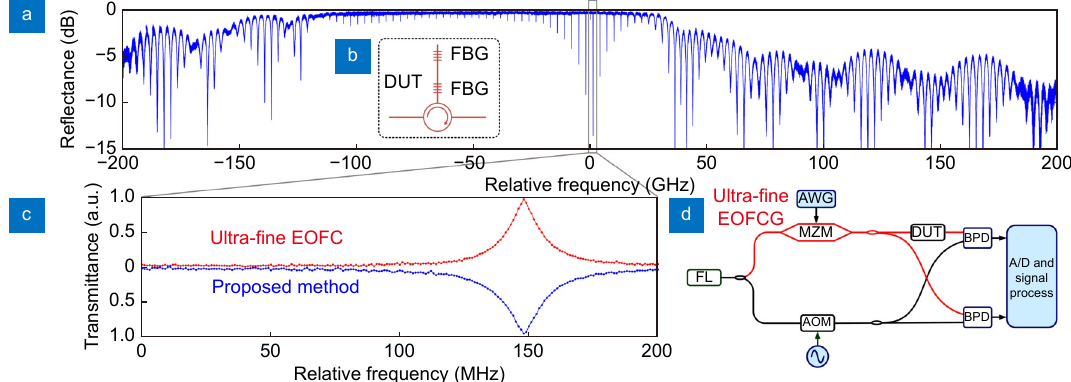
Fig. 5 | ( a ) Reflectance spectrum measured in 1.6 ms with 1 MHz resolution. ( b ) Experimental setup of the fiber F-P cavity with 3 GHz FSR. ( c ) Measurement results of the deepest resonance with 17 MHz FWHM by using proposed method and ultra-fine EOFC. ( d ) Experimental setup of UFEOFC-based high resolution spectroscopy for